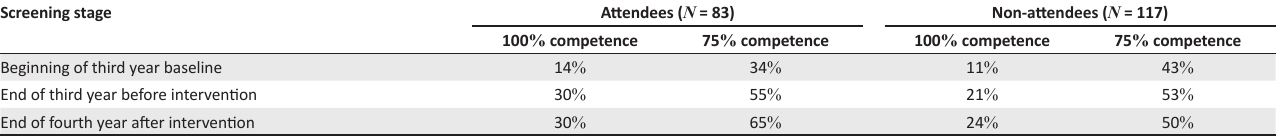
TABLE 3: Percentage of students competent before and after peer-teaching intervention ( N = 200). Screening